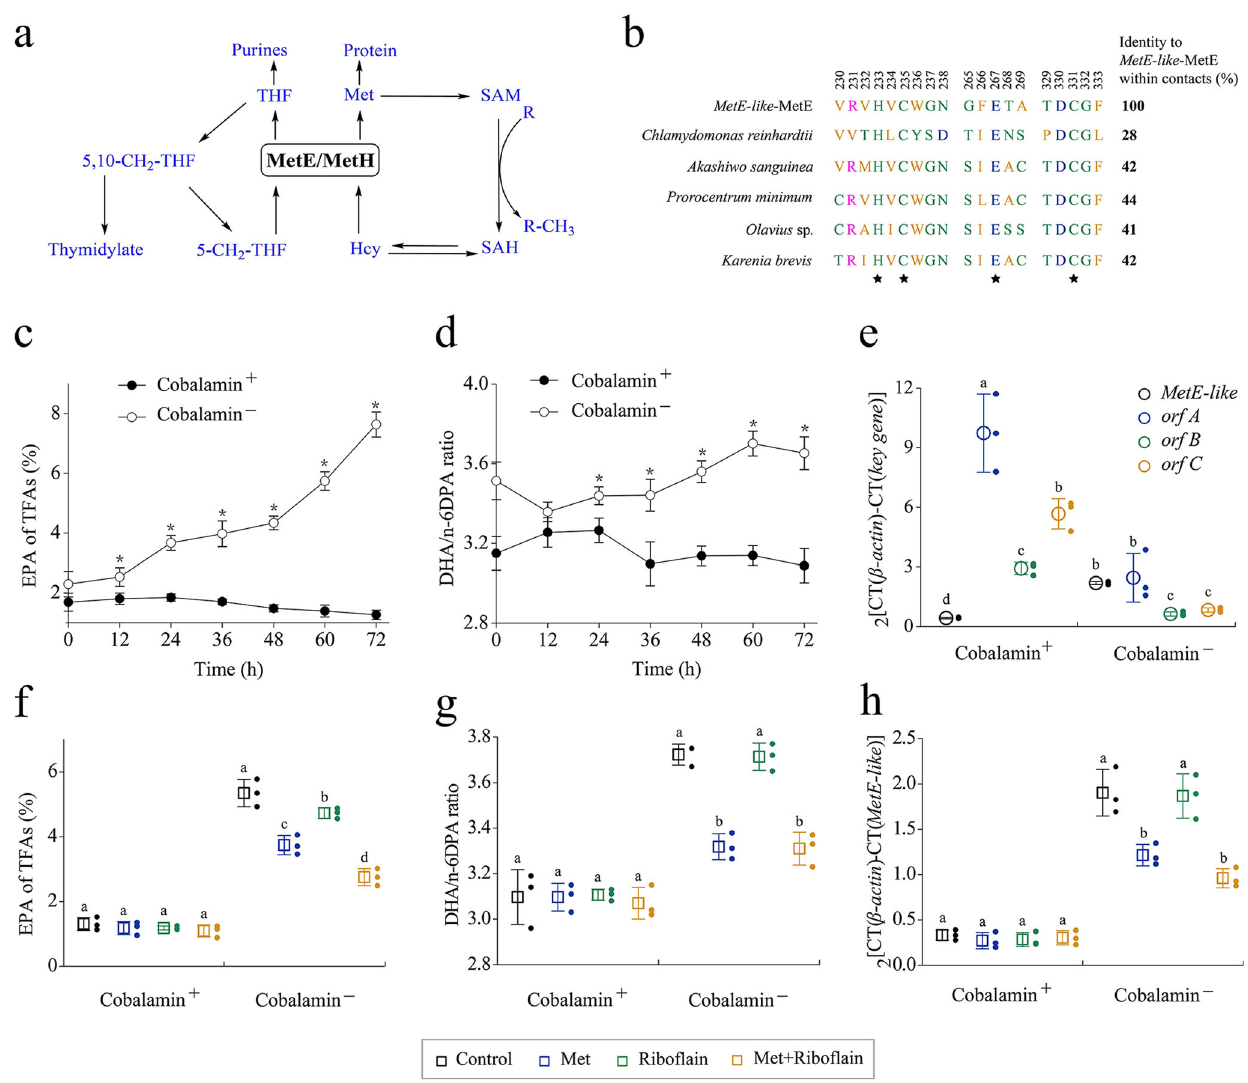
Fig. 4 Cobalamin controls the expression level of MetE-like . a Metabolic map of a portion of the C1 cycle centered around MetE and MetH, with enzyme abbreviations in black, metabolite abbreviations in blue, and arrows depicting enzyme-catalyzed reactions. Hcy Homocysteine, THF tetrahydrofolate, SAH S-adenosine homocysteine, SAM S-adenosyl methionine, 5-CH 2 -THF 5-CH 2 -tetrahydrofolate, 5,10-CH 2 -THF 5,10-CH 2 -tetrahydrofolate. b Multiple sequence alignment of MetE protein sequences from eight algae for the region spanning the functionally important conserved residues required for binding Zn 2 + (indicated by a black star), numerical values on amino acids represent the position of each amino acid in the MetE-like -MetE domain. c , d Time courses of EPA ratio ( c ) and DHA/n-6DPA ( d ) ratio between cobalamin + and cobalamin − of Schizochytrium sp. e Comparison of PKS genes and MetE-like transcript level between cobalamin + and cobalamin − of Schizochytrium sp. (60 h). f , g , h Effects of different addition schemes on EPA ratio ( f ), DHA/n- 6DPA ratio ( g ), and MetE-like transcript level ( h ) between cobalamin + and cobalamin − of Schizochytrium sp. (60 h). Letters above the bars indicate signi fi cant difference ( p ≤ 0.05), based on one-way analysis of variance (ANOVA) and Tukey ’ s honestly signi fi cant difference (HSD) test. The statistical signi fi cances of the fi nal results were analyzed by t-test, ∗ p <